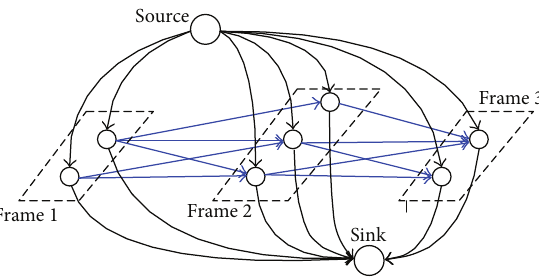
Figure 1: The simple flow network